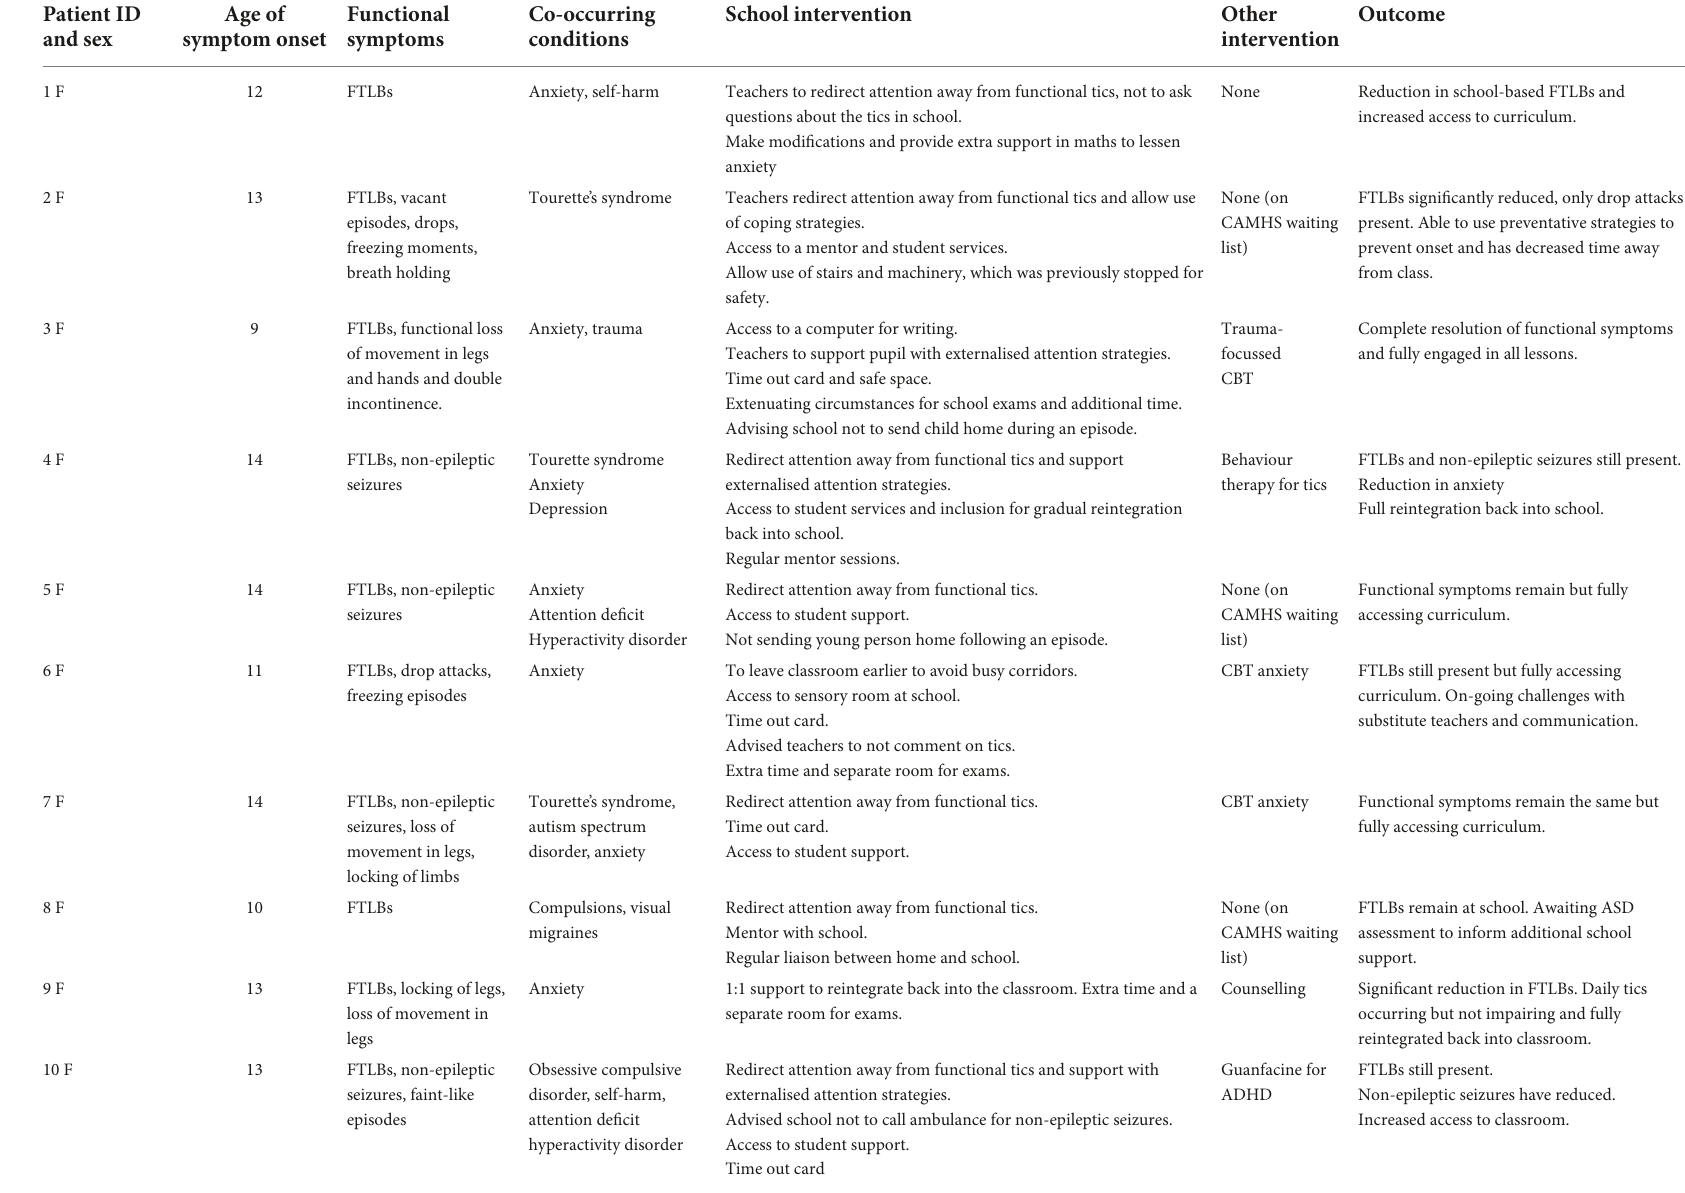
TABLE 1 Clinical characteristics, school intervention, and outcome of young people presenting with FTLBs. Patient ID and